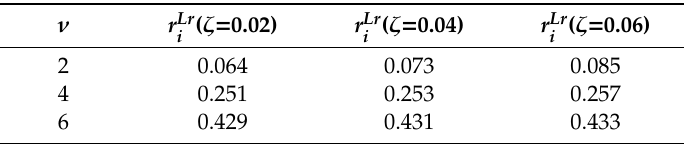
for di ff erent ν and ζ . i